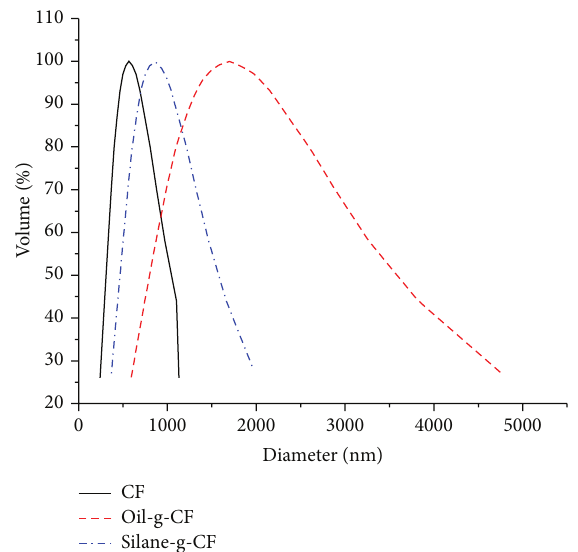
Figure 3: Particles size distributions of CF, Oil-g-CF, and Silane-g- CF by dynamic light scattering.